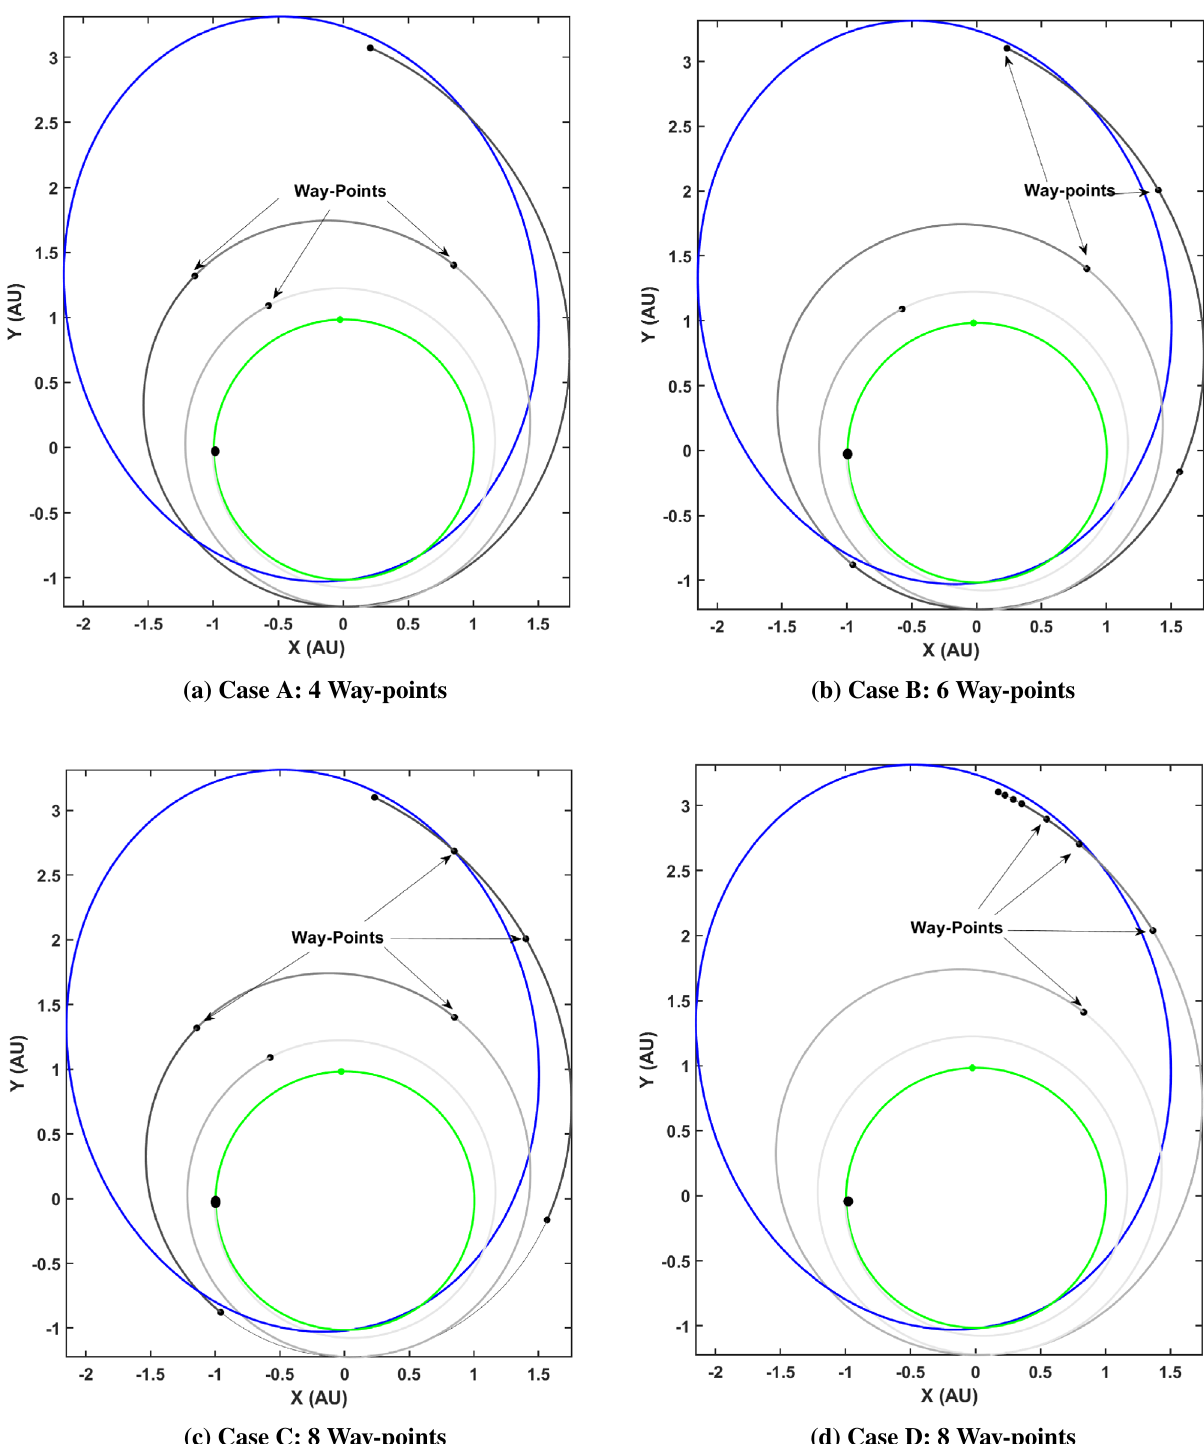
Figure 12. Case studies to explore the effect of frequency and location of way-points on guidance